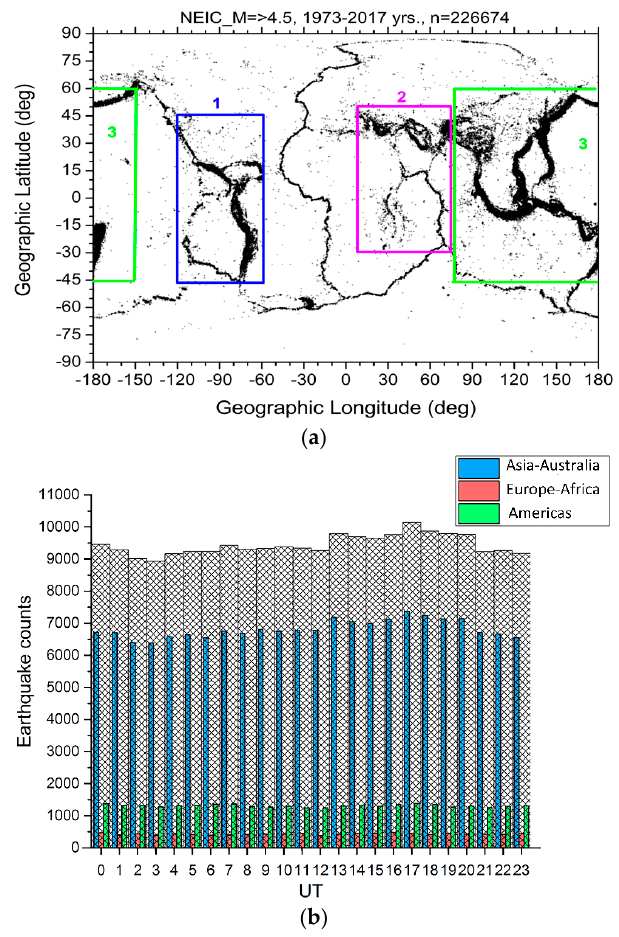
Figure 11. Top panel—longitudinal separation of the global seismic activity by three zones ( a ). Bottom panel—hourly number of earthquakes in different longitudinal zones for the period 1973–2017 ( b